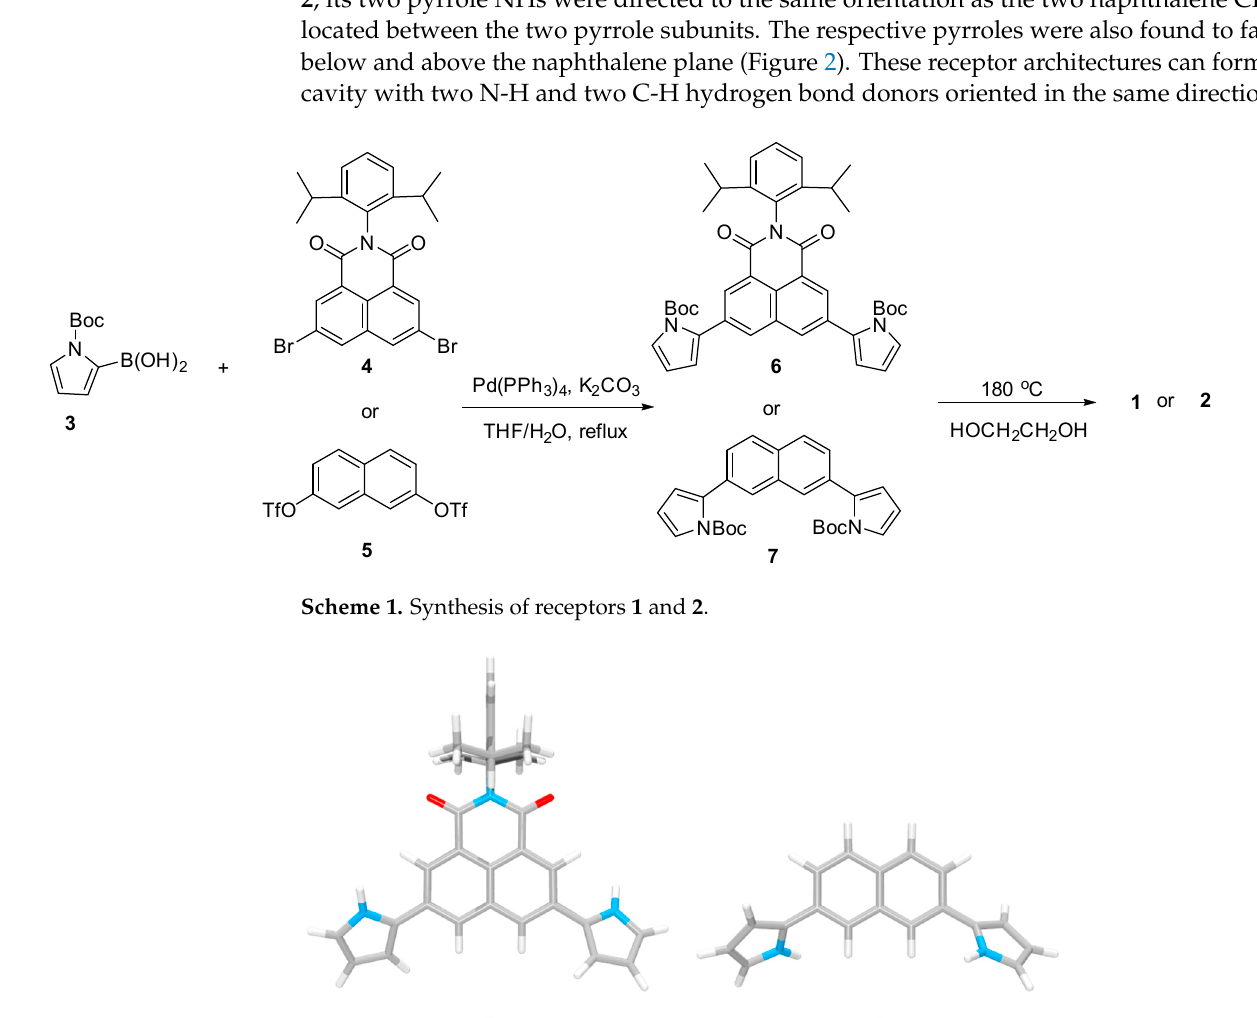
Figure 2. The lowest energy structures of receptors 1 and 2 .